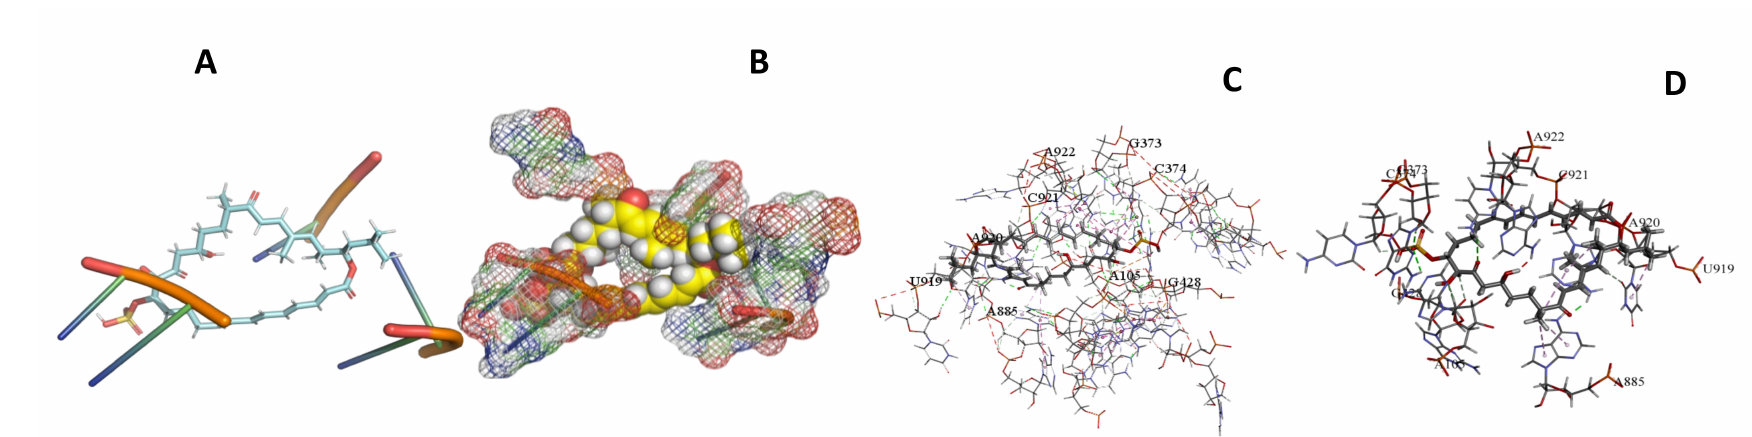
Figure 30. T. Brucei + Sulfangolid A. ( A ): Best binding pose and nucleotides involved. ( B ): Schematic binding pocket. ( C ): shows the Nucleotides component that re involved in binding. ( D ): Shows the main bonds involved between the compound and the nucleotide component.